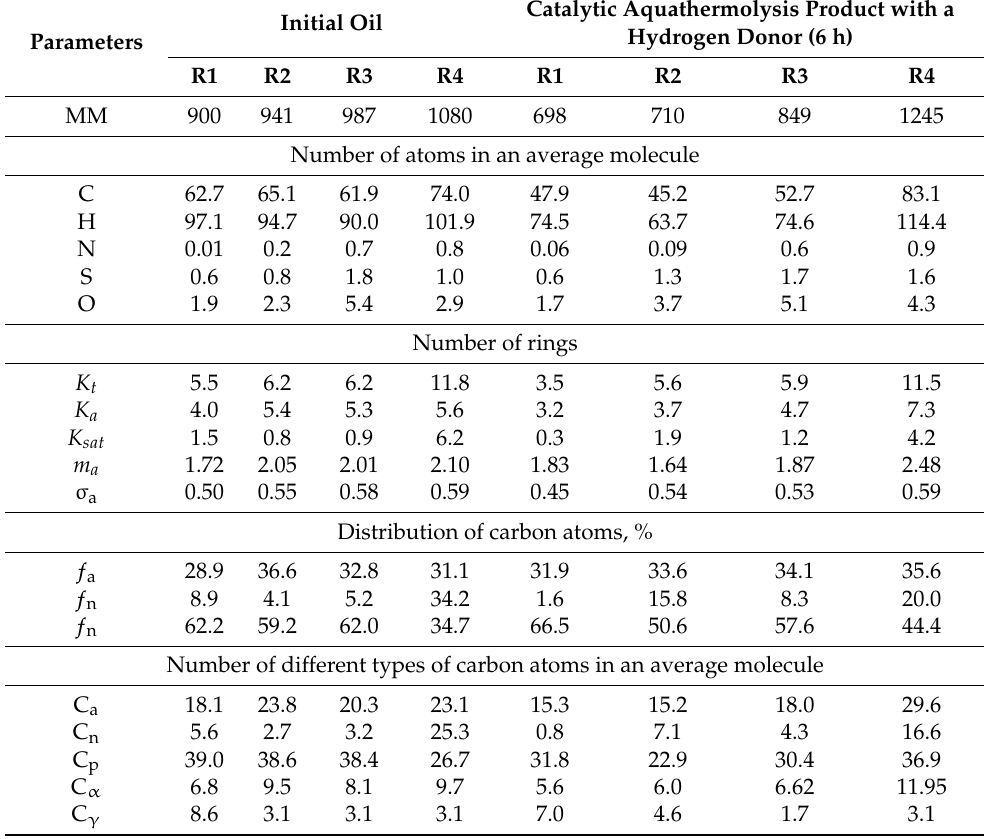
Table 2. Average physicochemical and structural parameters of the resin fraction molecules from the Ashalcha initial oil field and for the products of non-catalytic aquathermolysis.